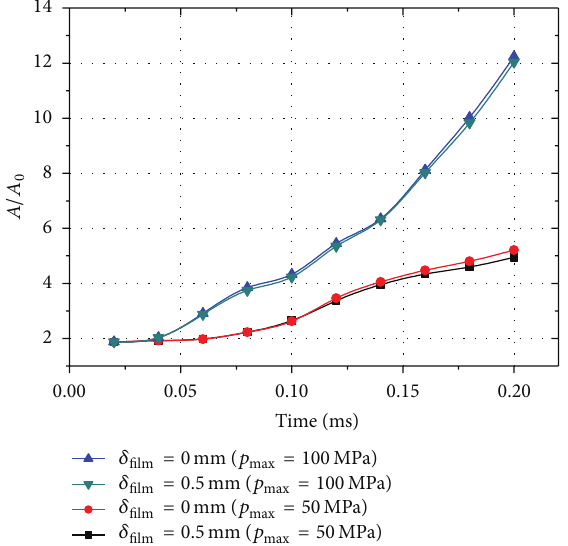
Figure 19: Aspect ratio of droplet diameter with time for the drop- lets with and without film (the peaks of pressure pulses are 100MPa and 50